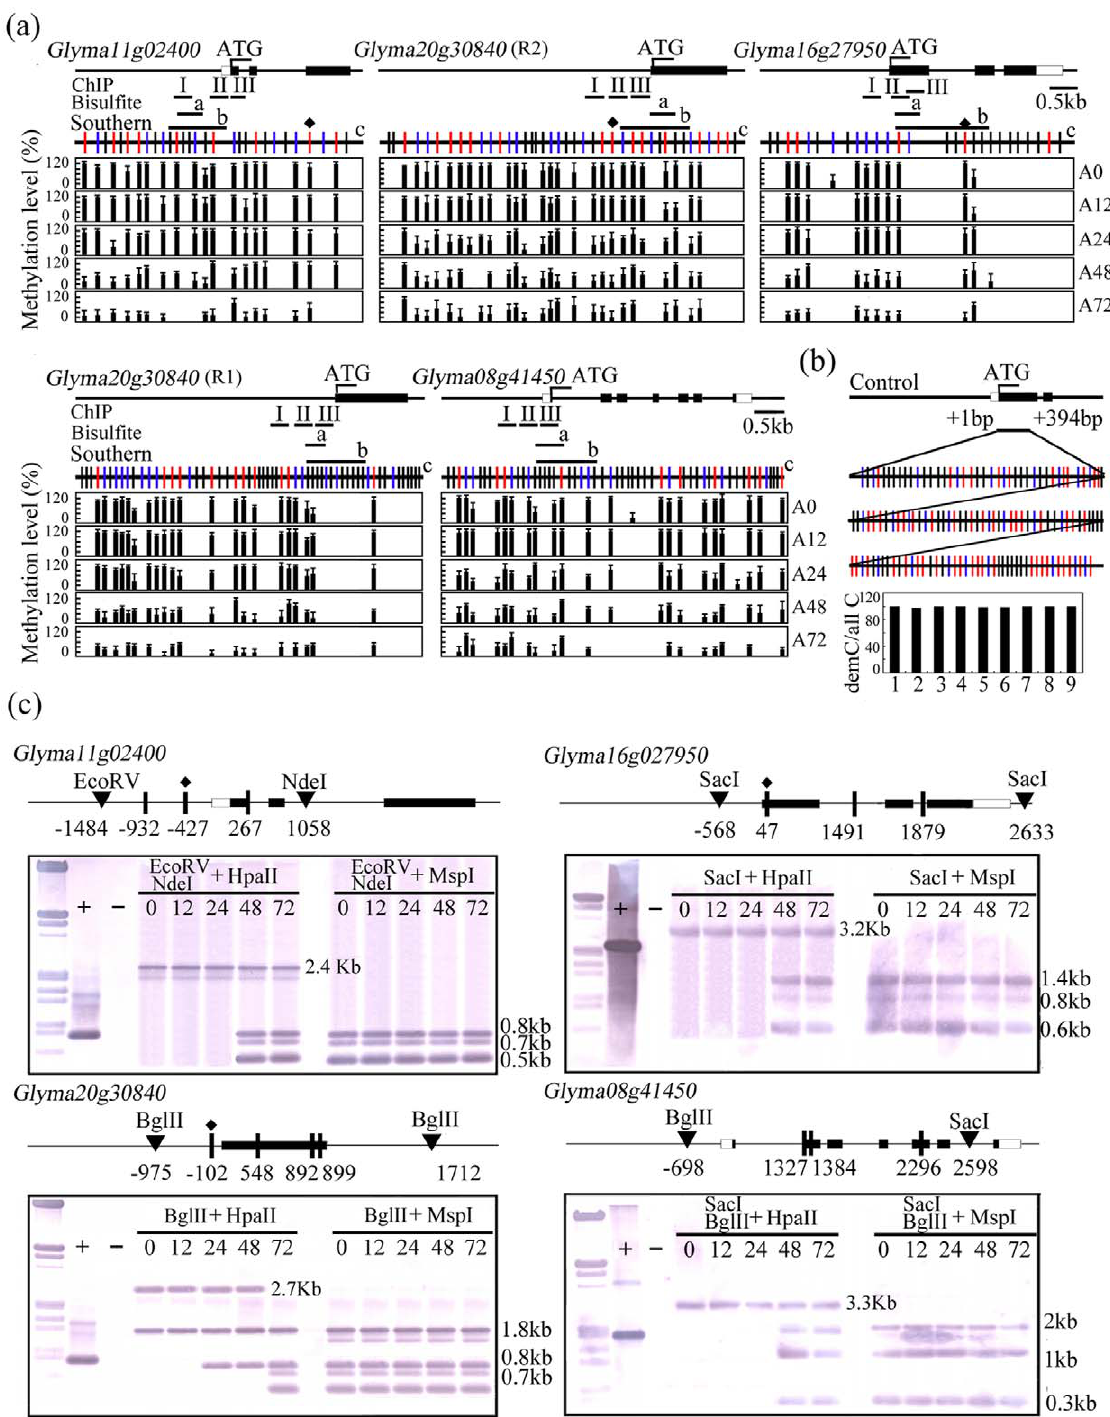
Figure 5. Promoter methylation status in four salinity-responsive TFs in non-treated (A0) and 5-ADC treated seedlings (A12–A72). For Figure legend please refer to Figure 3